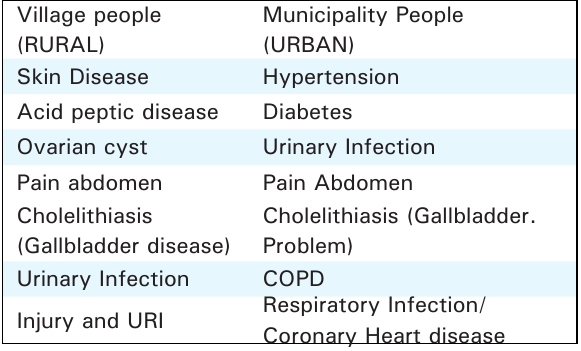
Table 4. Common Morbidity pattern of Outpatient Diseases